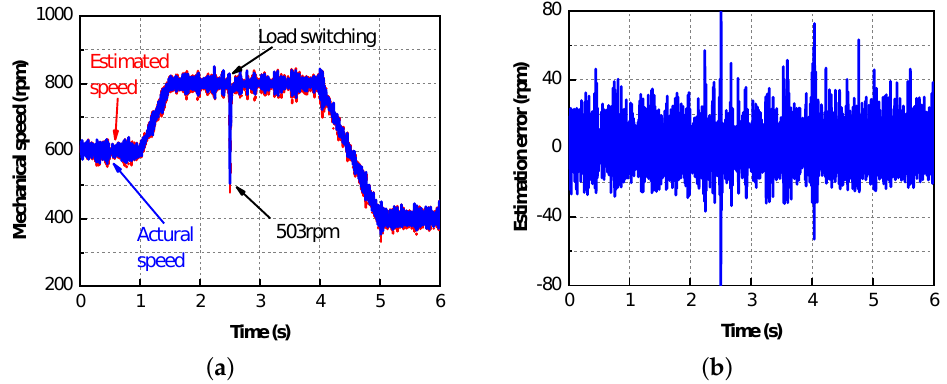
Figure 18. Simulation results of speed using the constant inductance. ( a ) Estimated speed and ( b ) estimation error.